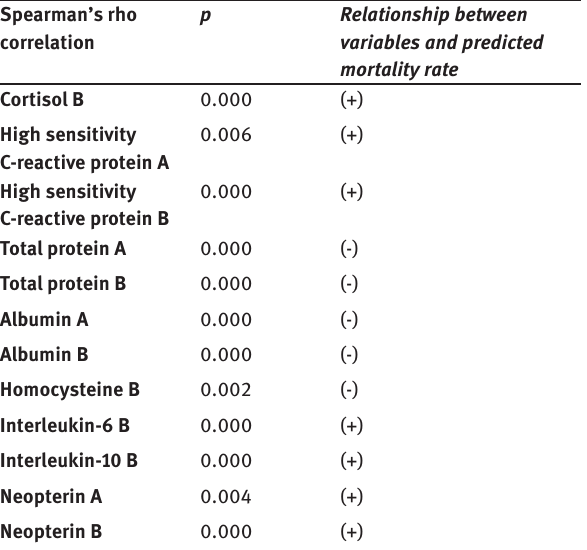
Table 3: When the predicted mortality rate was accepted as a dependent variable, twelve variables, which were not included in POSSUM scoring system originally, showed a highly significant correlation with the predicted mortality rate. (A: Pre-operative value; B: post-operative value). (-): inverse relationship between predicted mortality rate and variable, (+): positive relationship between